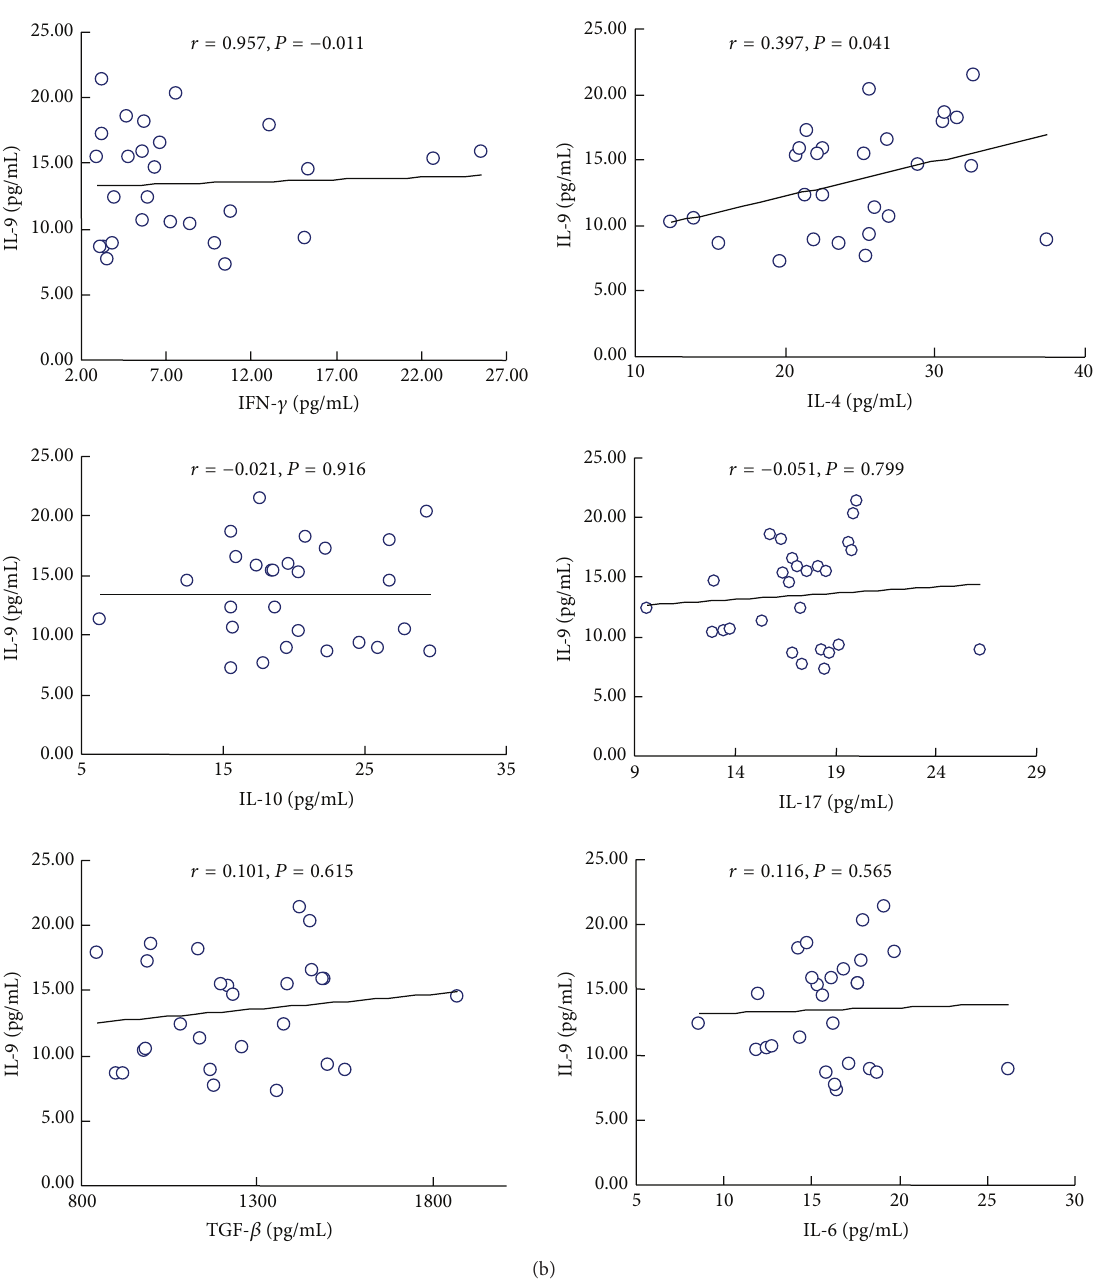
Figure 3: Th9 related cytokines changed in CE patients as determined by the CBA experiment. (a) Comparisons of levels of IL-9, IFN- 𝛾 , IL-4, IL-10, IL-17, TGF- 𝛽 , and IL-6 in HC, CE, and PCE groups. The horizontal bars indicated means. Comparison was performed using one-way analysis of variance. (b) In CE patients, IL-9 concentrations were correlated negatively with IFN- 𝛾 , IL-10, IL-17, TGF- 𝛽 , and IL-6 in CE patients ( 𝑟 = −0.011 , 𝑟 = −0.021 , 𝑟 = −0.051 , 𝑟 = 0.101 , and 𝑟 = 0.116 , resp.). IL-9 was positively correlated with the concentrations of IL-4 (𝑃 = 0.041 , 𝑟 = 0.397)